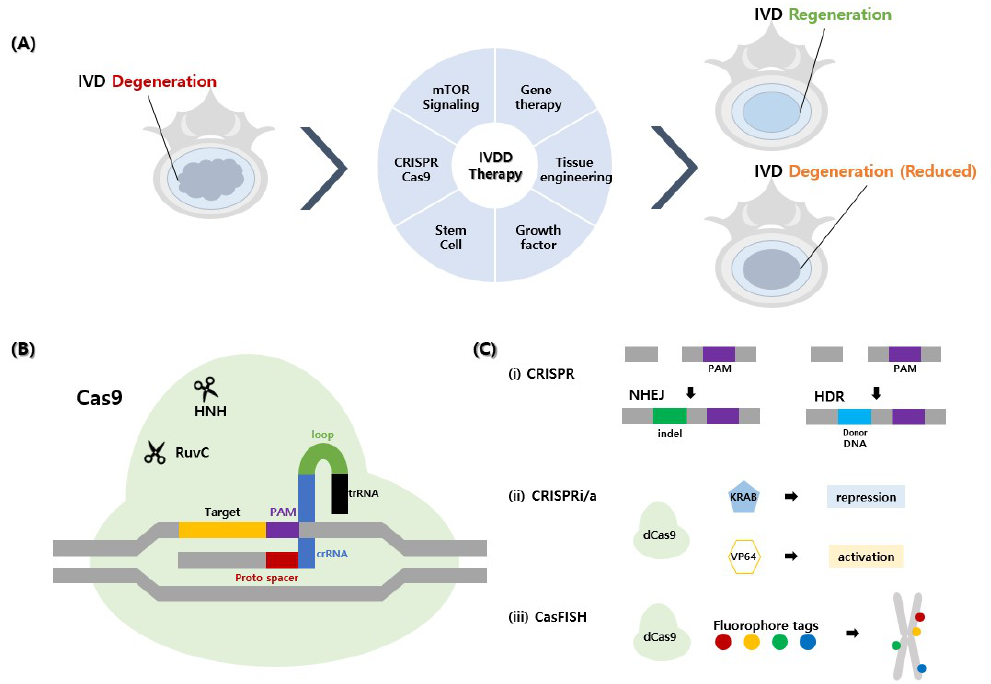
Figure 2. Schematic illustration of novel biological approaches and CRISPR-Cas9 as a gene therapy for the treatment of intervertebral disc degeneration (IVDD). Representative newly discovered biological approaches for the treatment of IVDD are shown as follows. ( A ) A simple diagram illustrating regeneration of IVDD using gene therapy, tissue engineering, growth factor, stem cell, CRISPR-Cas9, and mTOR signaling. ( B ) The form in which sgRNA, Cas9, and DNA are attached is called CRISPR-Cas9. sgRNA consisting of proto-spacer, crRNA, loop, and trRNA is cut and attached to the DNA proto spacer adjacent motif (PAM) sequence through Cas9 using HNH and Ruvc scissors. ( C ) The recovery mechanism of CRISPR-Cas9 in the intervertebral disc is as follows: (i) non-homologous end joining (NHEJ) of CRISPR inserts or deletes indels, and homology-directed repair (HDR) inserts new segments of DNA. (ii) CRISPR interference (CRISPRi) and CRISPR activation (CRISPRa) use dead Cas9 (dCas9) as a technology to mediate transcription site gene expression but have no cleavage effect and guide-target DNA at the start site of transcription. When combined with the KRAB domain, it inhibits transcription, and when combined with VP64, it activates the transcription of target DNA. (iii) Cas9-mediated fluorescence in situ hybridization (CASFISH) is dCas9, which enables DNA observation using fluorophore tags (multicolor). CRISPR: clustered regularly interspaced short palindromic